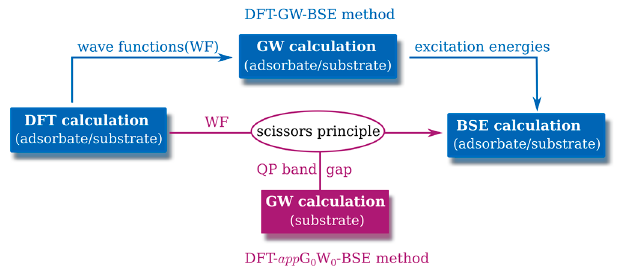
Figure 1. Schematic illustration of DFT-GW-BSE [31–33] and DFT- app G 0 W0-BSE.